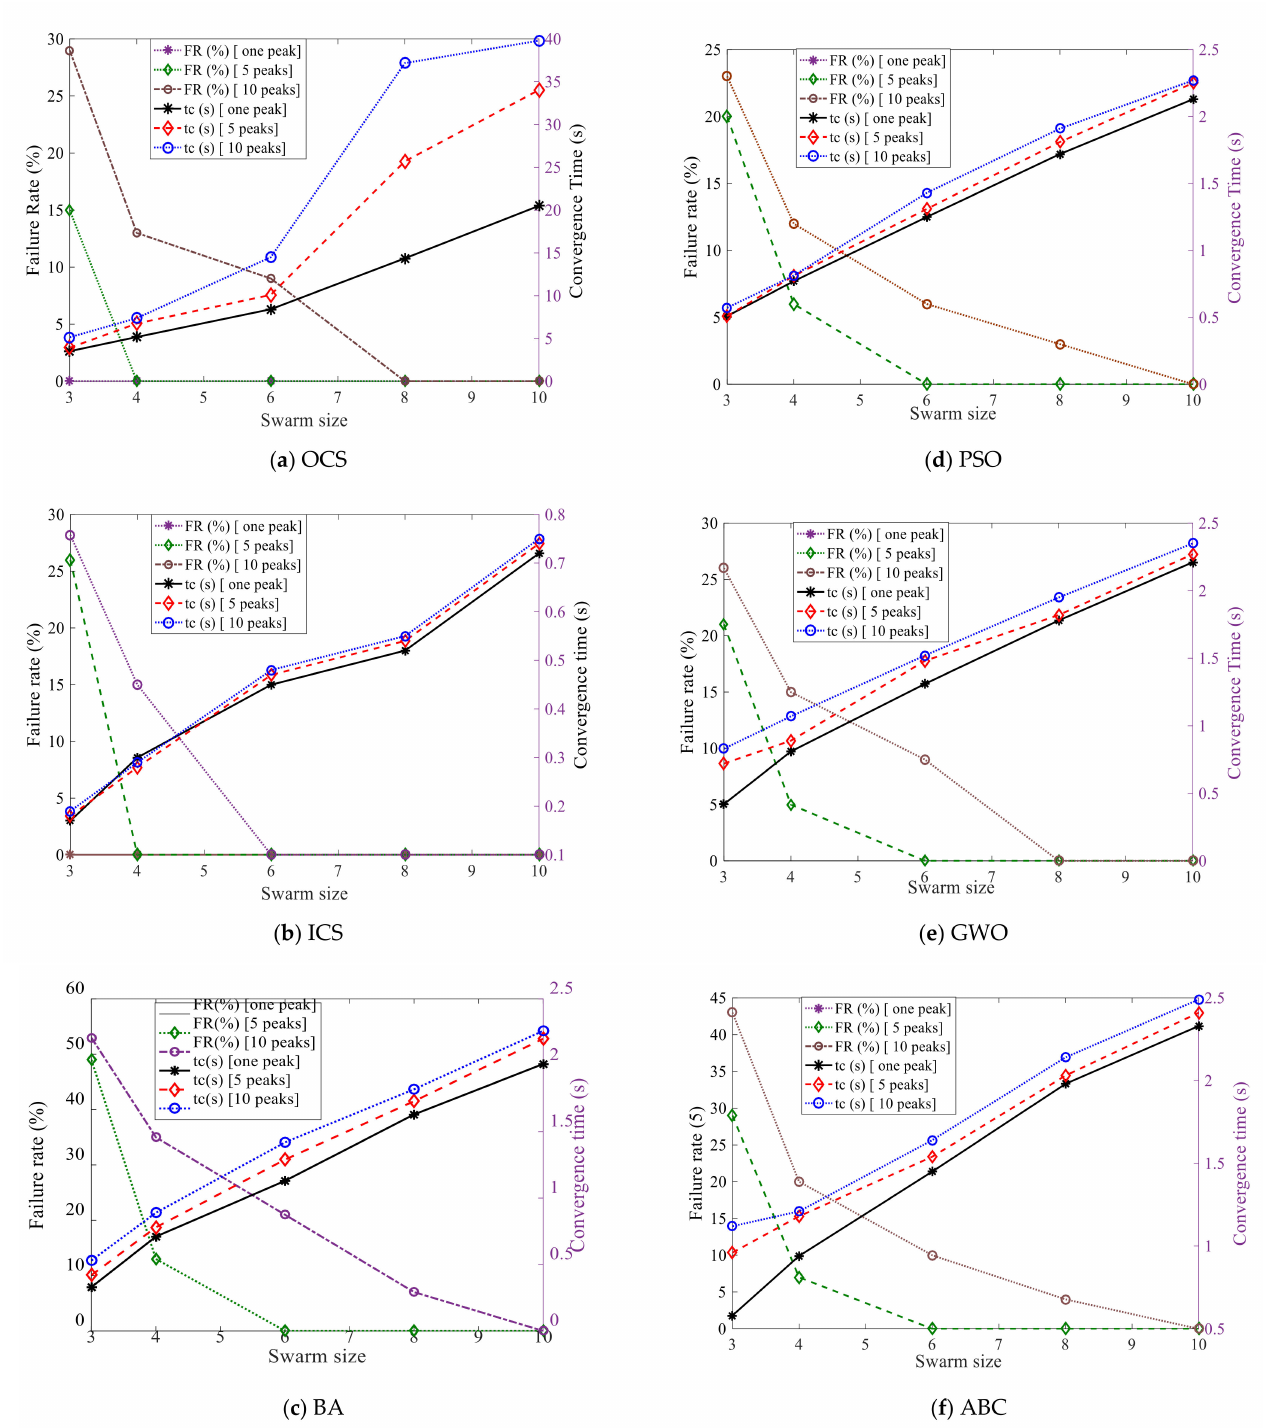
Figure 10. The variation of failure rate and convergence time along with swarm-size for a different number of peaks of all SOTs under